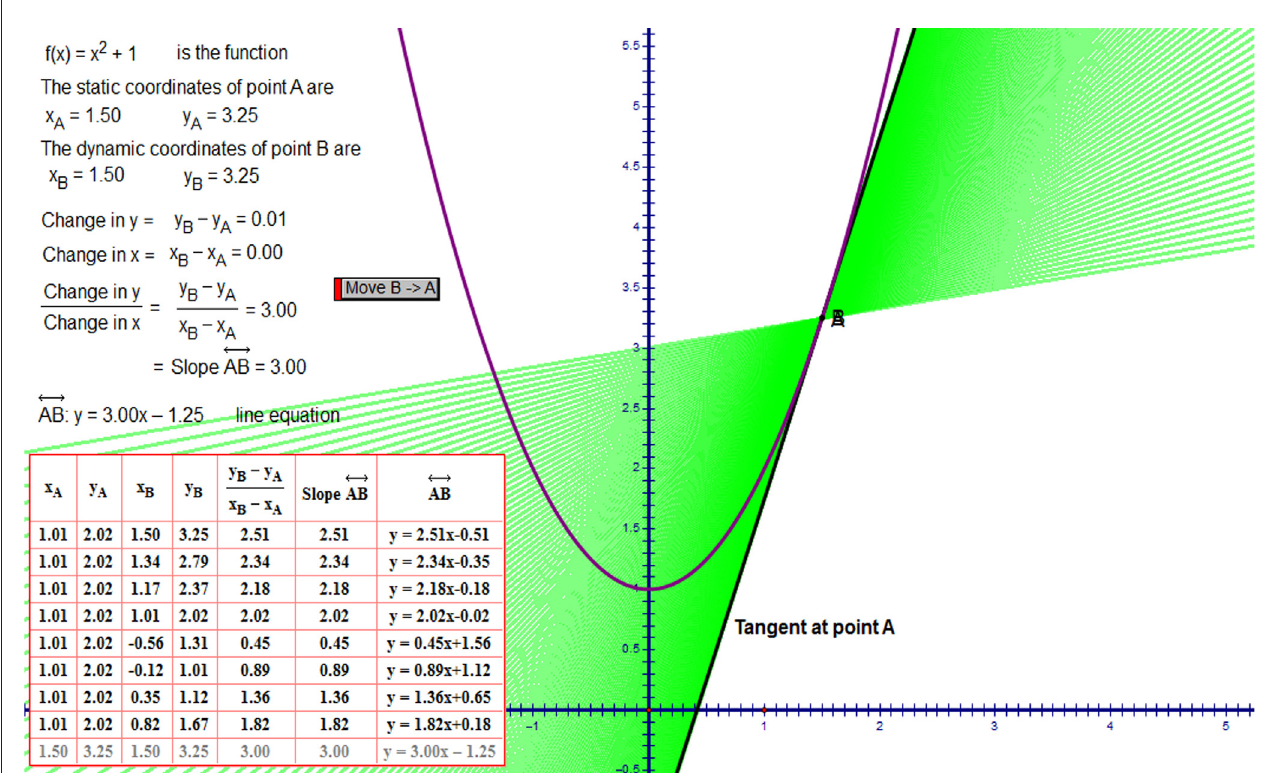
FIGURE 3: Modelling instantaneous rate of change in